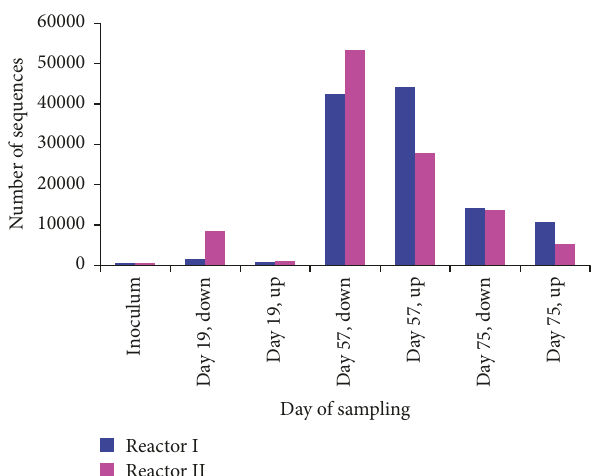
Figure 6: Dynamics of the number of methanogenic reads sequenced during the time course of microalgae and sodium acetate AD. “Up” and “down” labels next to the day of sampling refer to the upper or bottom part of the sampled sludge bed.